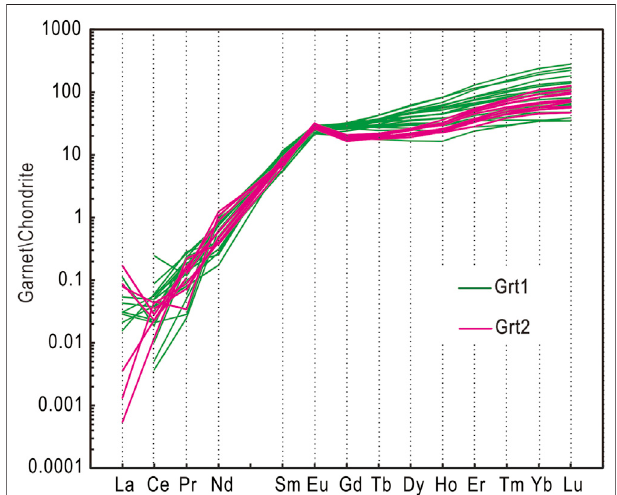
FIGURE 7 | Chondrite-normalized REE patterns of garnets from the Tiemurt deposit determined by LA-ICP-MS.